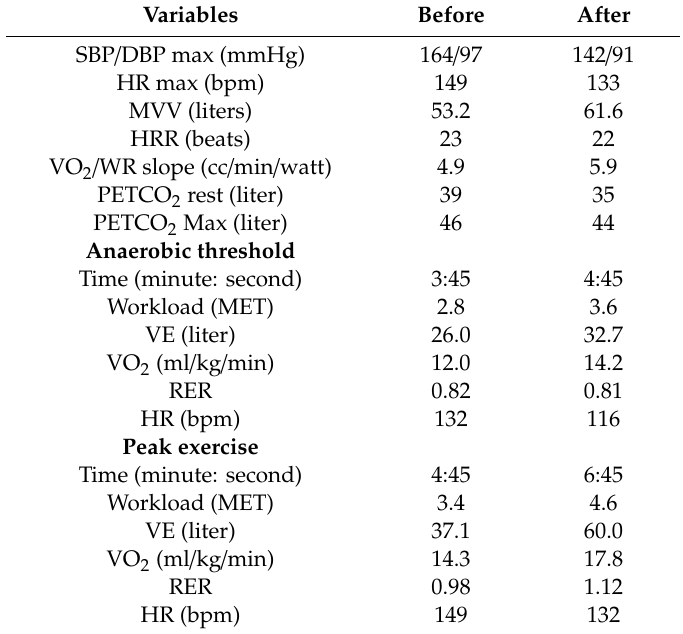
Table 2. Cardiopulmonary exercise test (CPET) results before and after exercise training programs. Variables Before